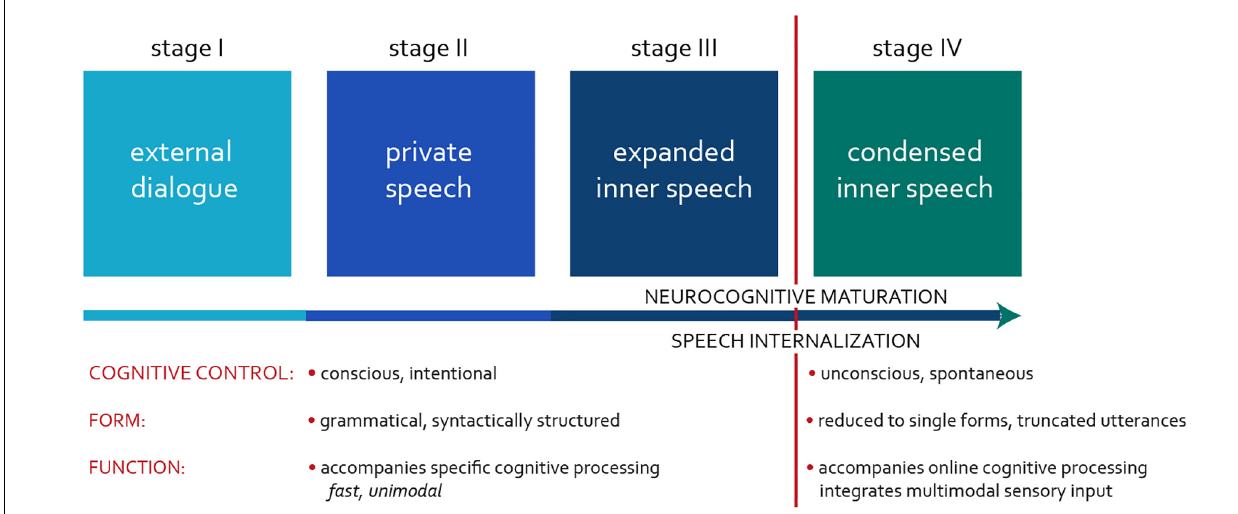
FIGURE 1 | Schematic representation of stages of IS